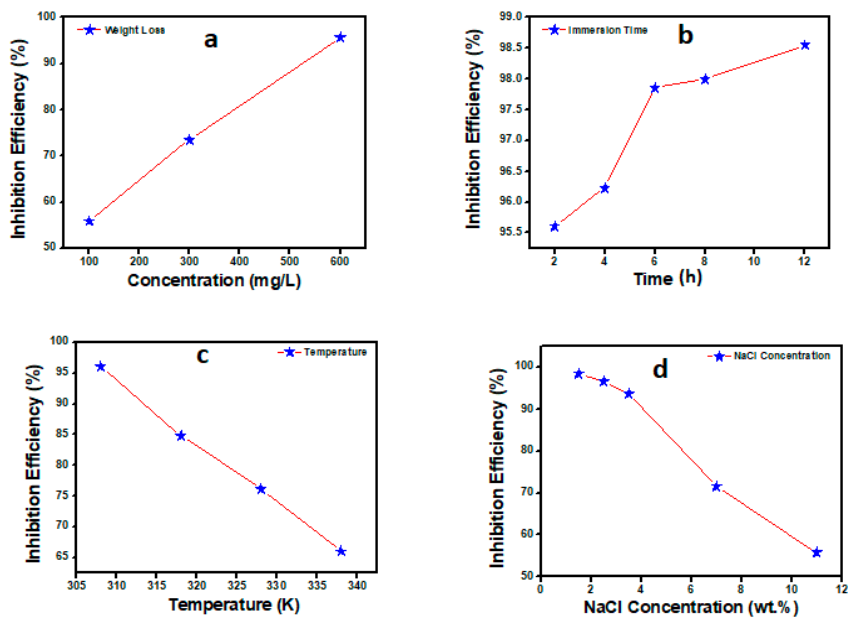
Figure 3. ( a ) Variation of inhibition efficiency (%) with inhibitor concentration. ( b ) Variation of inhibition efficiency (%) with immersion time. ( c ) Variation of inhibition efficiency (%) with temperature. ( d ) Variation of inhibition efficiency (%) with NaCl concentration.